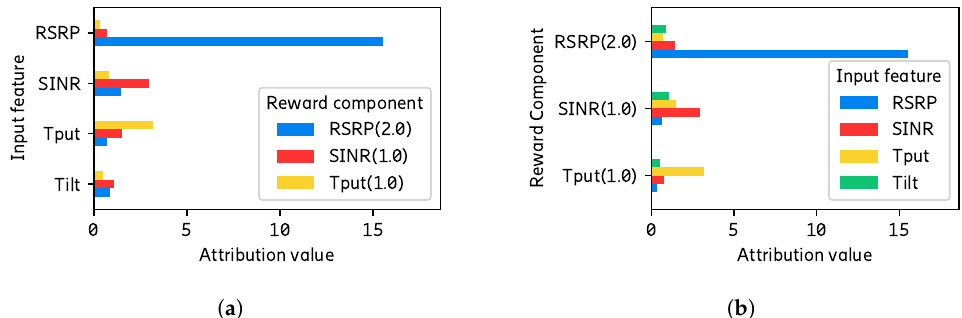
Figure 6. Explanations generated using BEERL at the RL level where the respective reward prioritiza- tion (k; shown in parentheses) is applied to the every component. ( a ) Decomposed feature importance at the RL level. ( b ) Decomposed feature importance presented per reward component at the RL level.